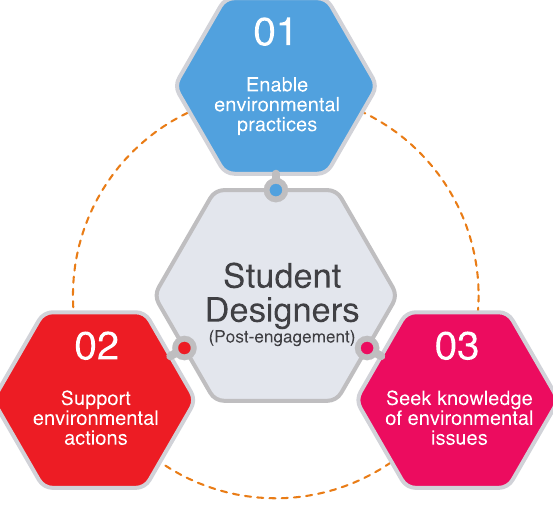
Figure 5. Final thematic map from the student designer pre‐engagement focus group